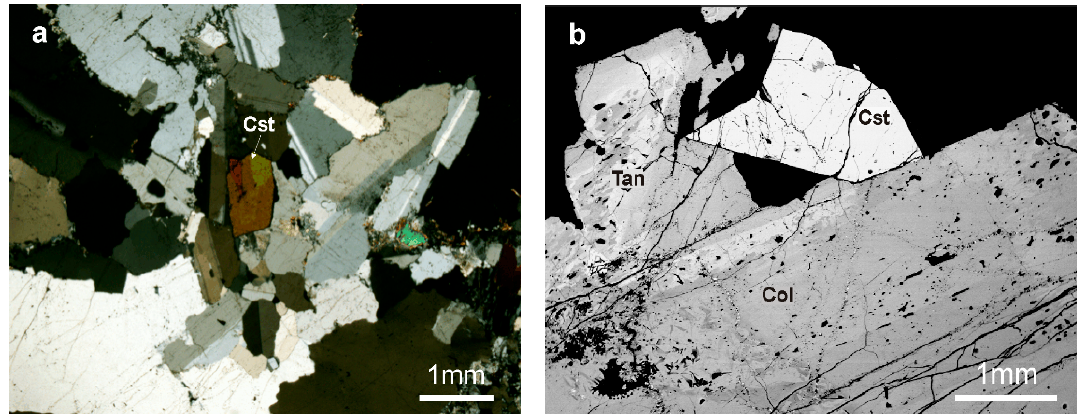
Figure 15. Cassiterite from type-V pegmatites. ( a ) Zoned crystal of cassiterite associated with quartz and albite in albite veins; ( b ) Twinned crystal of cassiterite associated with columbite and tantalite.